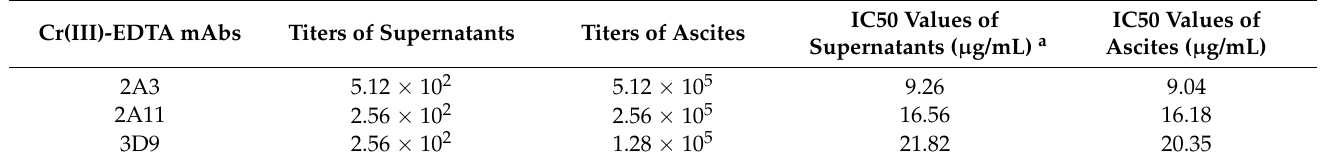
Table 1. The titers and IC50 values of Cr(III)-EDTA mAbs generated by three hybridomas.